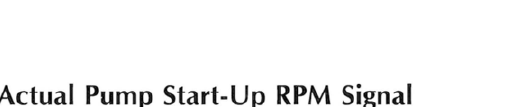
FIGURE 11 Pseudo Wigner-Ville distribution of transient speed of the pump. (a) PWVD and (b) con tour